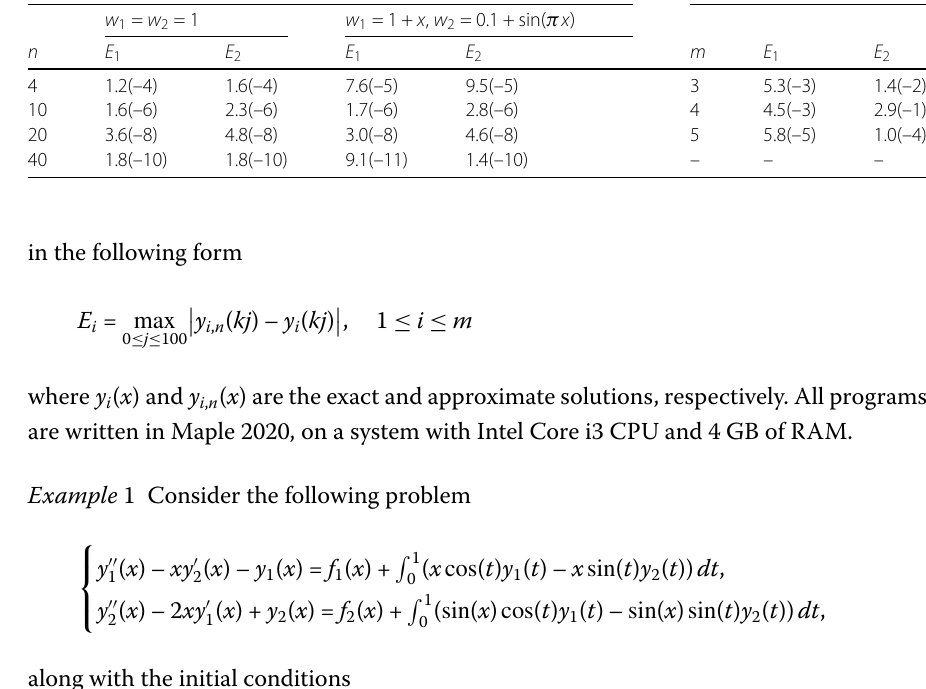
Table 1 The maximum absolute errors at the equidistant point for Example 1 Presented